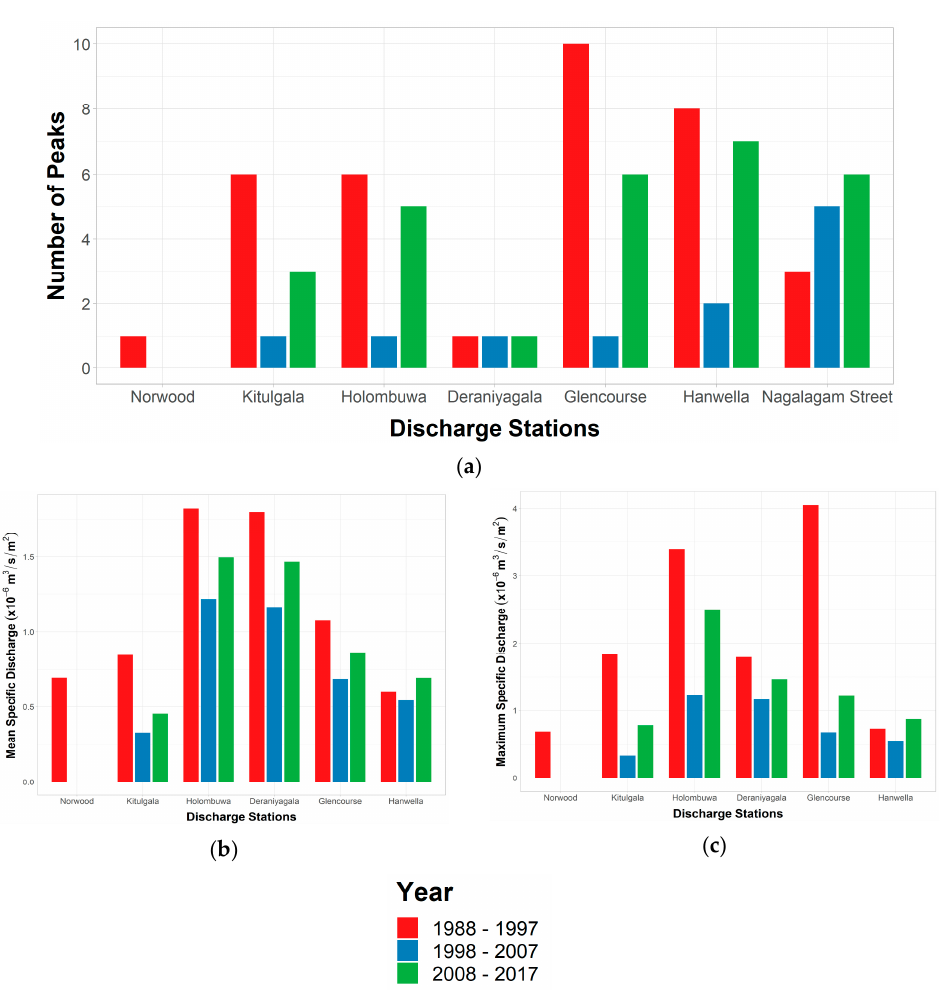
Figure 4. Results of the POT analysis: ( a ) Number of peaks recorded in each subbasin; ( b ) Mean specific discharge; ( c ) Maximum specific discharge.